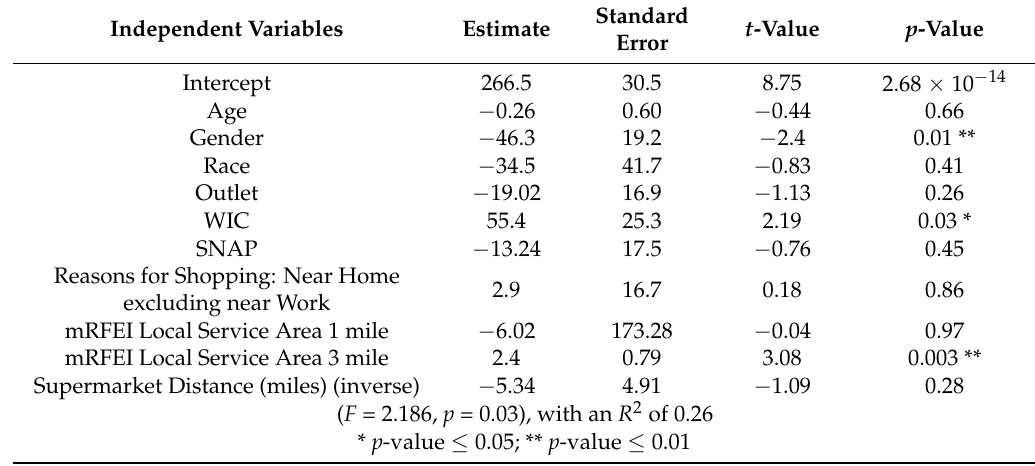
Table 4. Adjusted regression analysis, with skin carotenoids as the dependent variable and mRFEI Localized Service Area 1 and 3 miles as independent